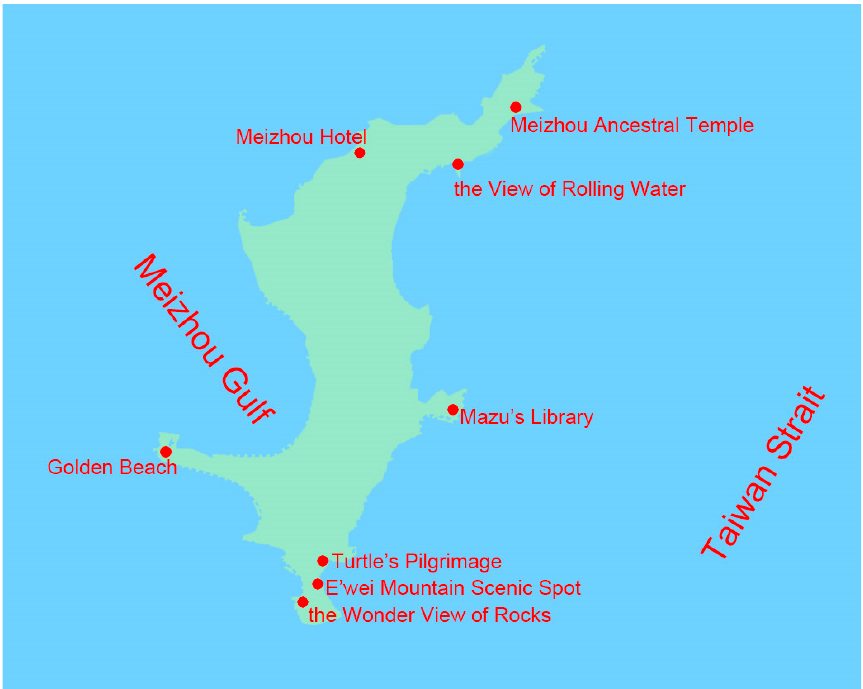
Figure 1. The statue named “the Goddess of Peace.” Source: Author’s photograph.